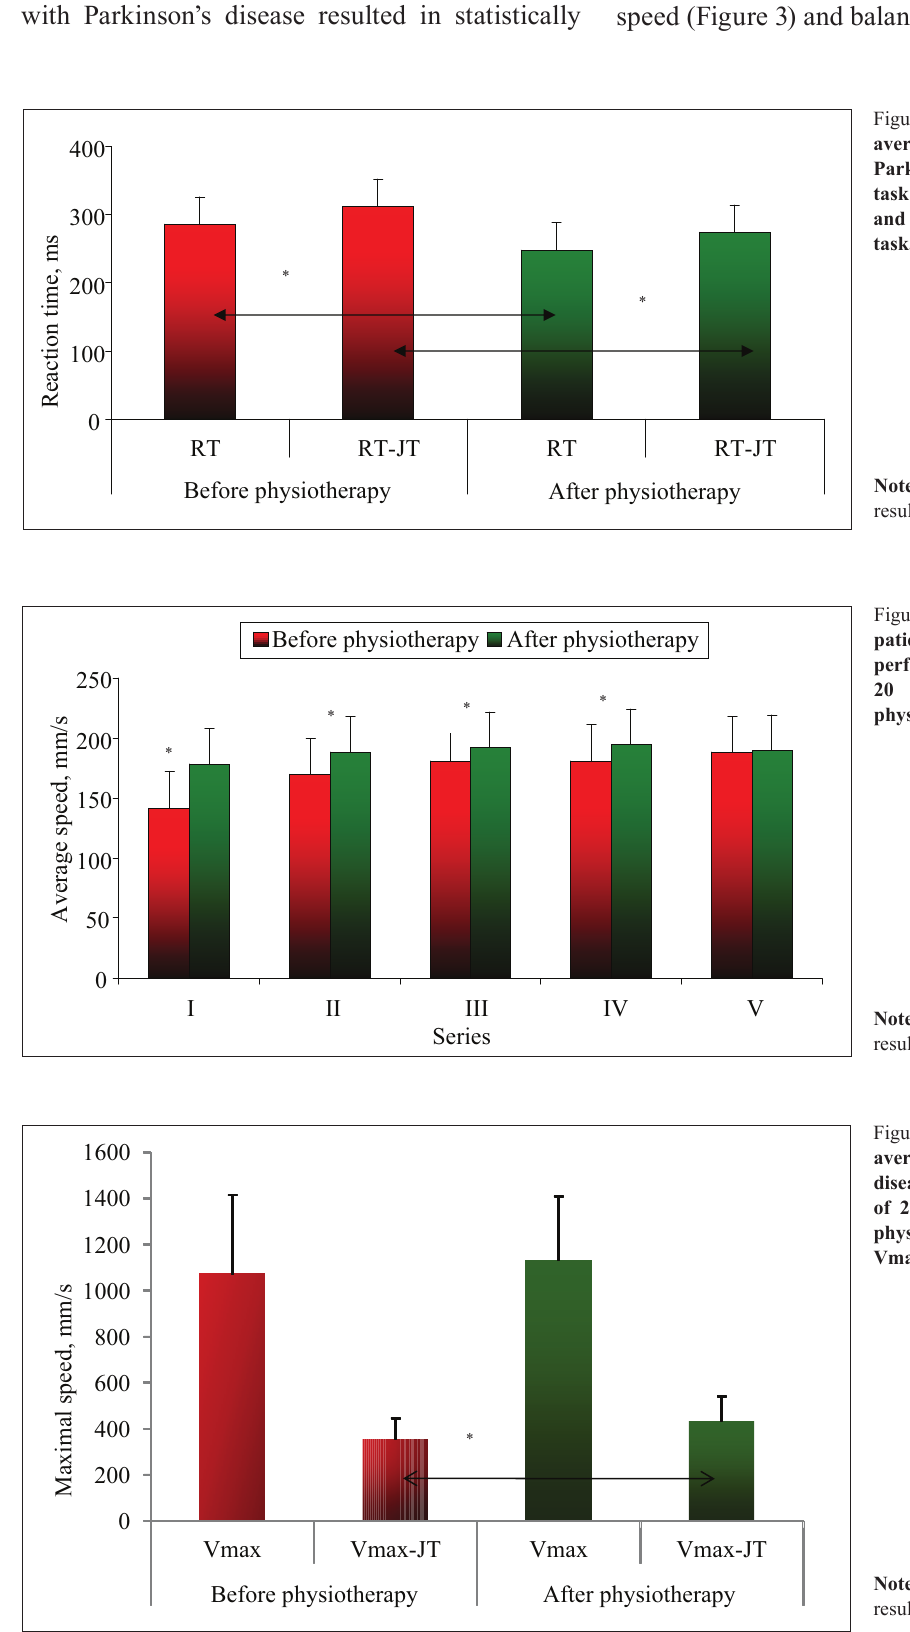
Figure 3. Maximal speed (mm/s) averages in patients with Parkinson’s disease performing a task of 5 sets of 20 repetitions before and after physiotherapy. Vmax -simple task, Vmax-